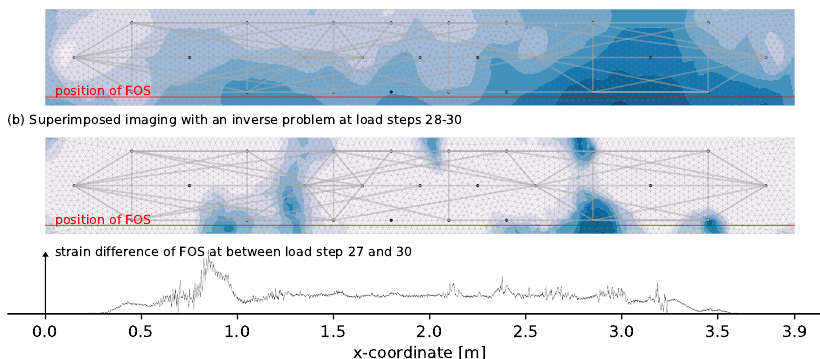
Figure 11. Evaluation of the change between load step 27 and 30 with the two different methods of imaging from Sections 2.4 and 2.5 shown in ( a , b